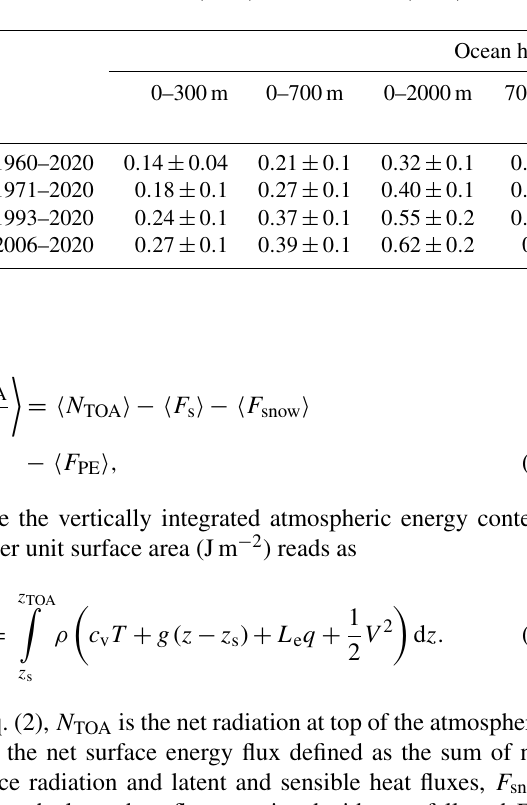
Table 1. OHC trends using LOWESS (locally weighted scatterplot smoothing; see text for more details) as derived from the ensemble mean (Fig. 2) for different time intervals, as well as different integration depths. The regression was done for each time period (1960–2020, 1971– 2020, 1993–2020, 2006–2020). A time window of 25 years was used for the periods that allowed it (1960–2020, 1971–2020, 1993–2020). For the period 2006–2020, a time window of 15 years was used. Note that values are given in watts per square meter (Wm − 2 ) relative to the global surface (a factor of 0.61 for the ocean surface is used considering the area 60 ◦ S–60 ◦ N, > 300m bathymetry). See also text and Figs. 2–3 for more details. Additionally, values for satellite-derived estimates of OHC have been added for the most recent period, which are updated after Hakuba et al. (2021) and Marti et al.